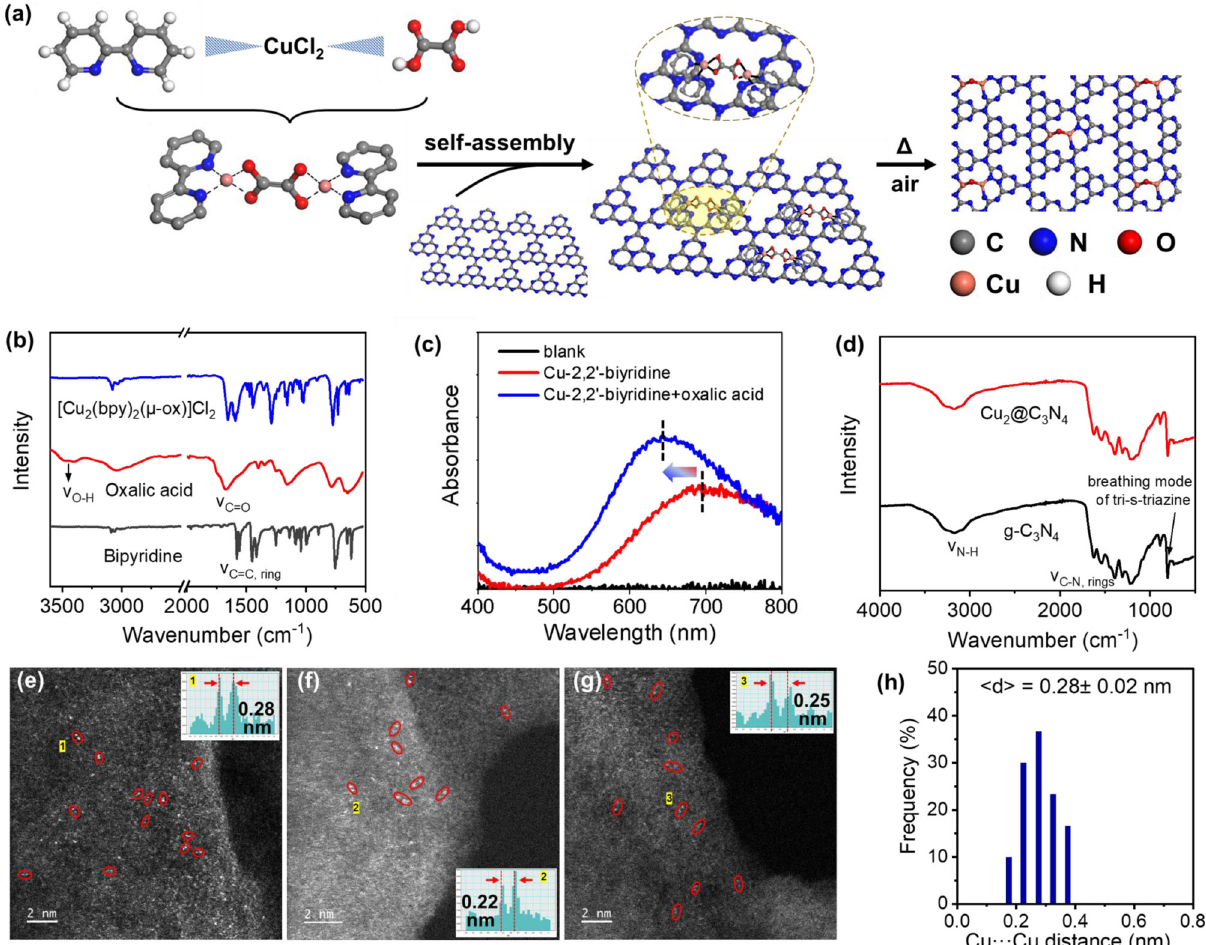
Fig. 1 Synthesis of the Cu 2 @C 3 N 4 catalysts. a Scheme illustration of synthetic route. b , c Characterization of the Cu-dimer precursor, [Cu 2 (bpy) 2 ( μ -ox)] Cl 2 complex, using FTIR ( b ) and UV-vis DRS ( c ). d Comparison of FTIR spectra for Cu 2 @C 3 N 4 and g-C 3 N 4 . e – g Representative HAADF-STEM images of Cu 2 @C 3 N 4 , with the insets showing line-scanning intensity pro fi les of Cu dimers. h Statistical distribution of the Cu-Cu distance in the Cu dimers derived from the STEM